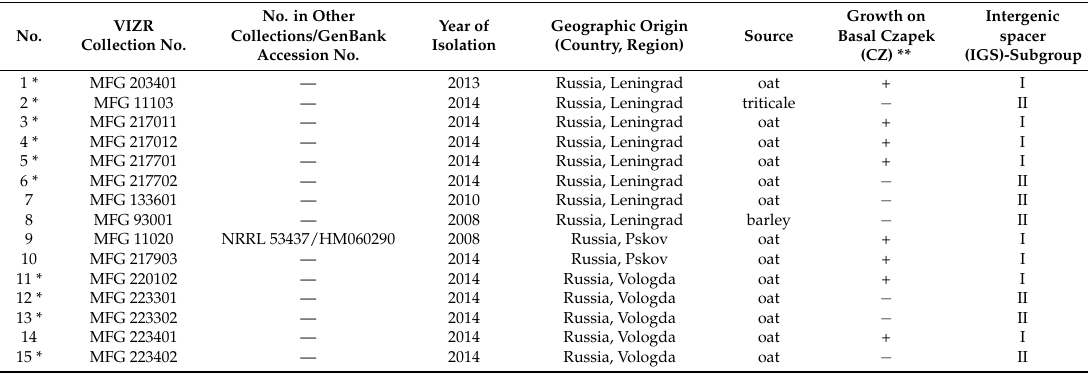
Table 1. Fusarium langsethiae strains used in the present